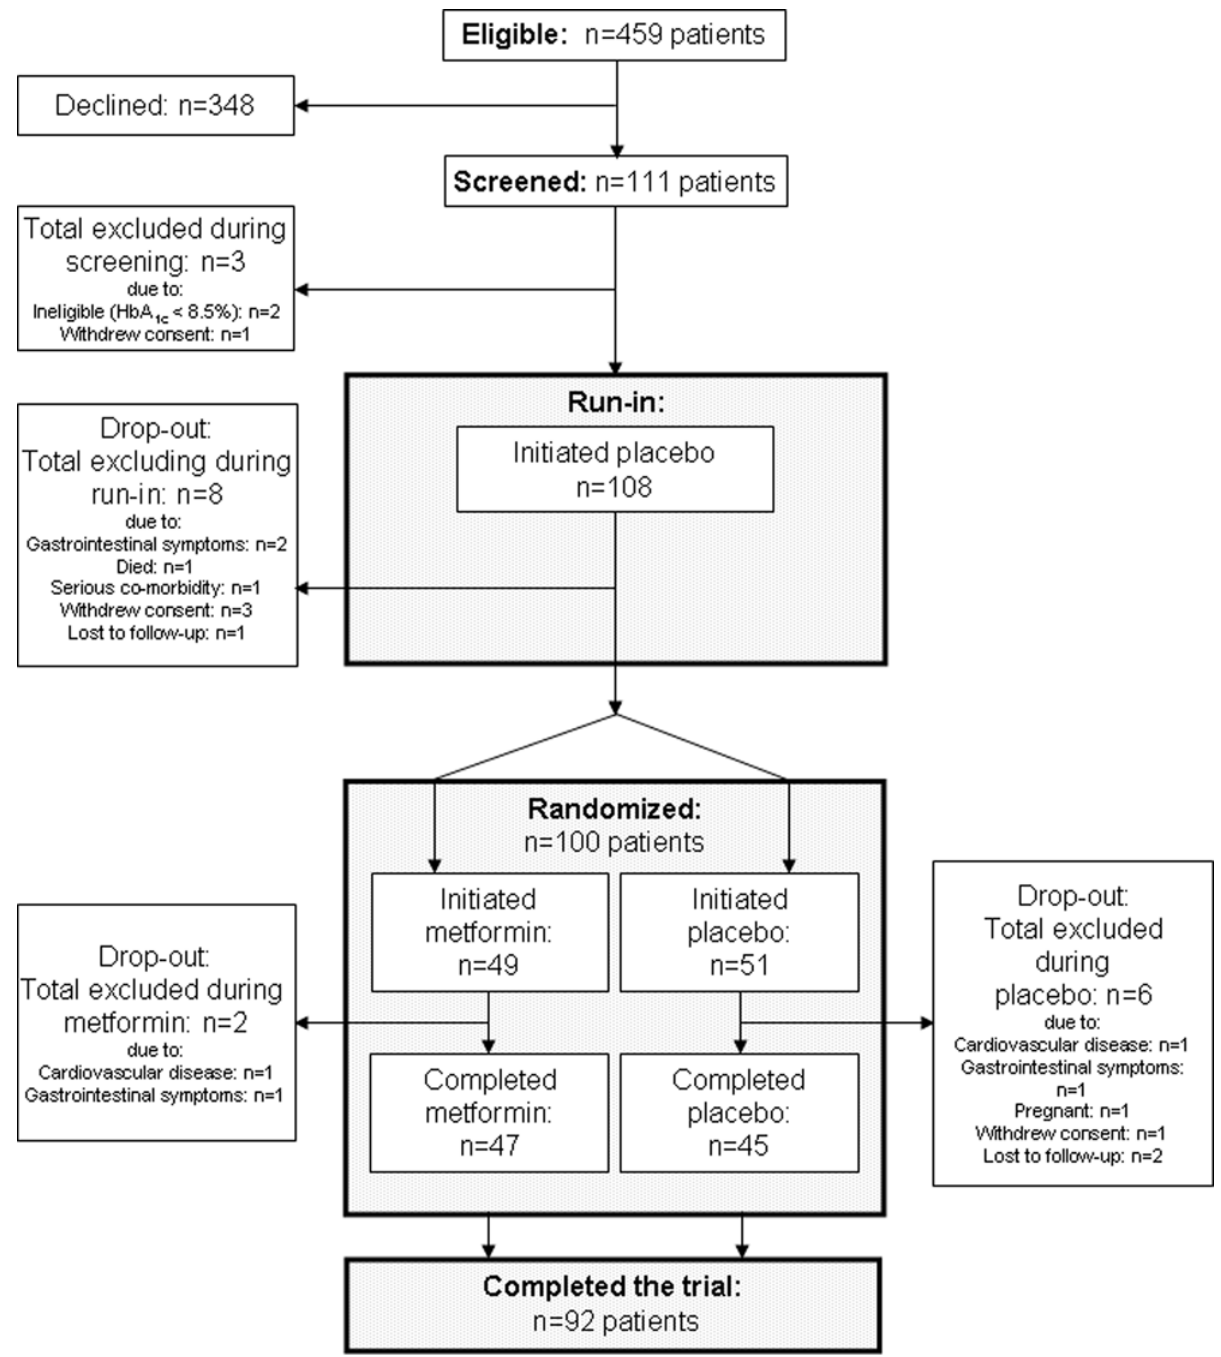
Figure 1. Patient flow scheme.